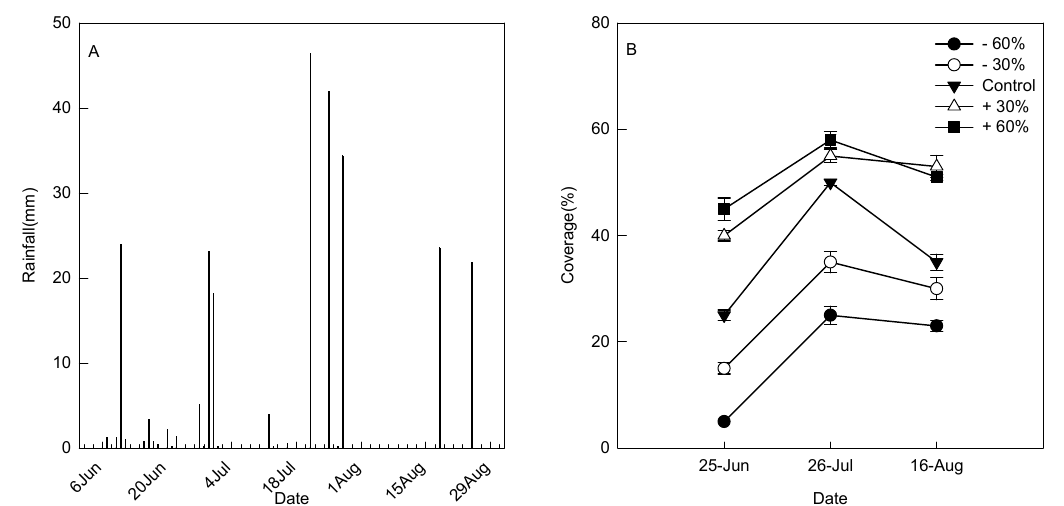
Figure 2. Rainfall change during the study period ( A ) and the influence of different precipitation treatments on plant coverage ( B ).